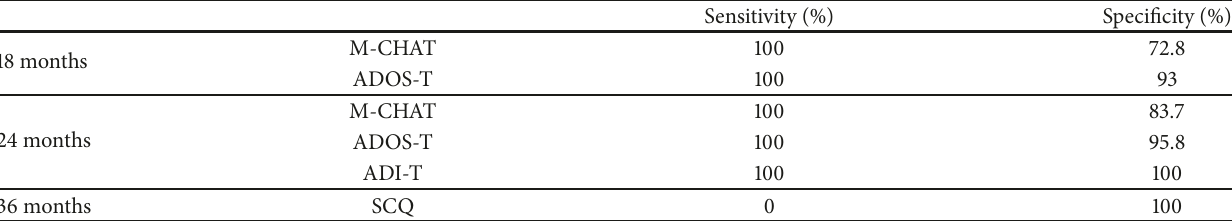
Table 3: Sensitivity and specificity of the autism spectrum disorder measures .